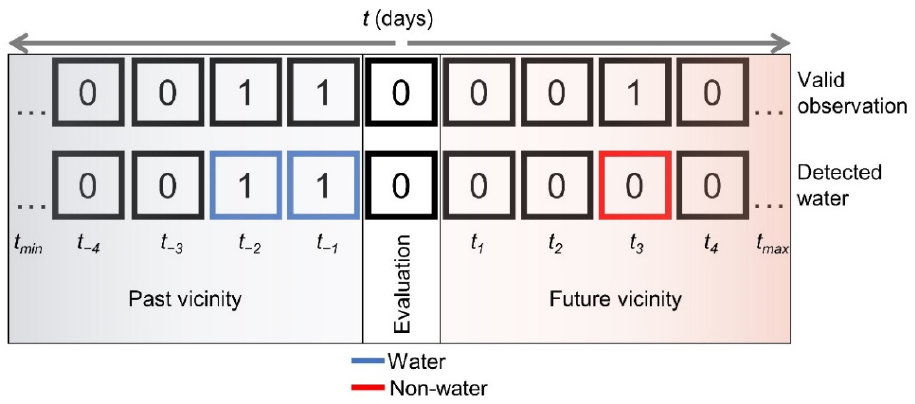
Figure 4. Pixel representation of temporal neighbors in the past and future vicinity. Here, an 8-day past/future vicinity was considered and the water probability for the evaluated pixel would be 2/3 with a reliability of 3/9. Binary assessment: 1 ≙ true and 0 ≙ false.